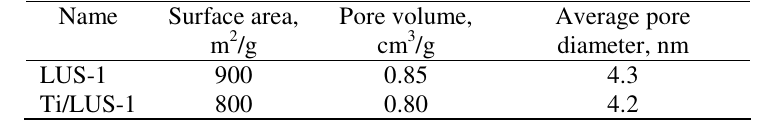
Figure 2 . Nitrogen adsorption-desorption isotherms of LUS-1 and Ti/LUS-1. Table 1. Surface area, pore size, and pore volume of Ti incorporated in the uncalcined samples of LUS-1 before and after the